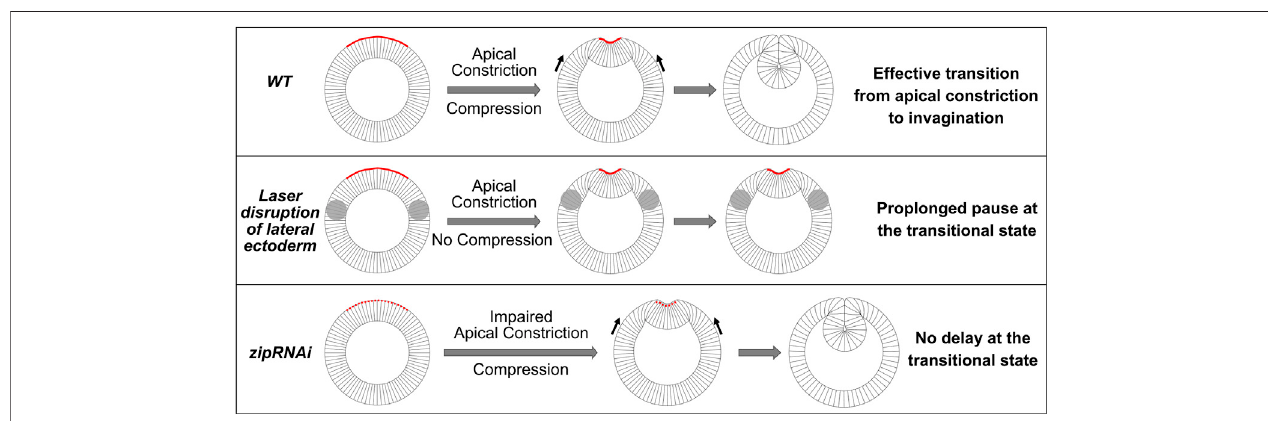
FIGURE 9 | Drosophila mesoderm invagination requires a joint action of apical constriction and in-plane compression. Cartoon demonstrating the proposed coordination betweenapical constriction inthemesoderm andin-planecompression from theectoderm duringmesoderm invagination. Wepropose thatthecombined actionofapicalconstrictionandcompressionfacilitatesmesoderminvaginationbytriggeringepithelialbuckling.Whenectodermalcompressionisabsent(e.g.,whenthe lateral ectoderm is disrupted), transition from apical constriction to invagination is greatly delayed, and the embryo pauses at the transitional state for an extended time. On the other hand, reducing the rate of apical constriction (e.g., zip RNAi embryos) per se does not cause delay at the transitional state. In such scenarios, the presence of ectodermal compression facilitates the transition between apical constriction and invagination once the mesoderm epithelium arrives a stereotyped intermediate con fi guration.